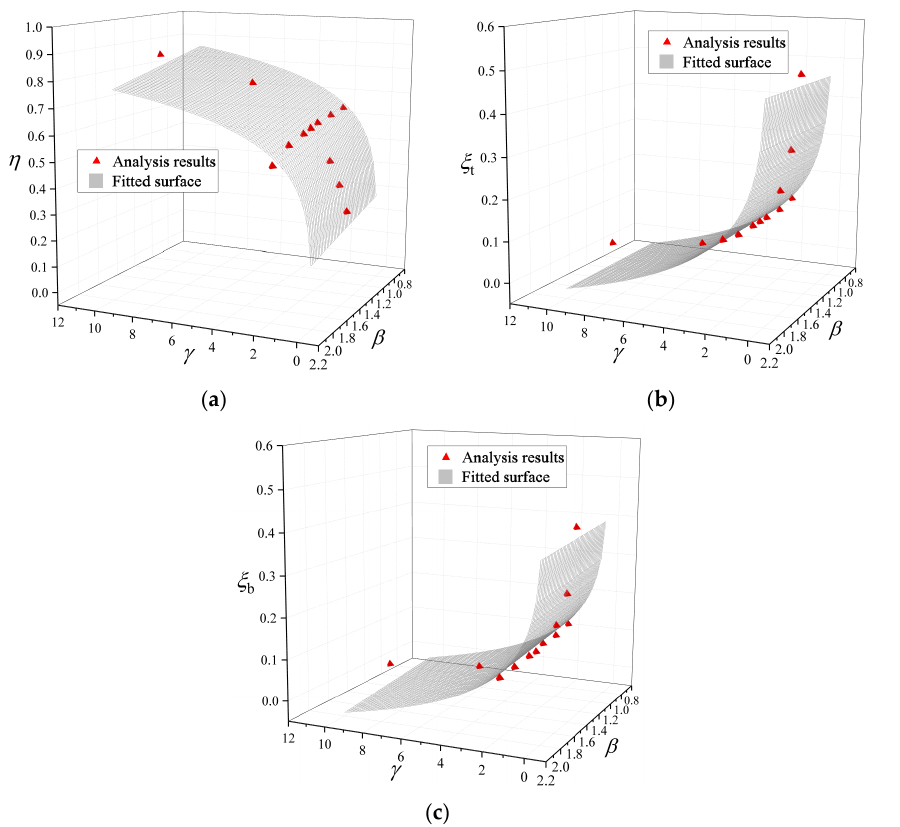
Figure 9. Surfaces of fitting formulas: ( a ) Stiffness reduction coefficient and ( b ) bending moment adjustment coefficient for upper end of sidewalls; ( c ) bending moment adjustment coefficient for lower end of sidewalls.